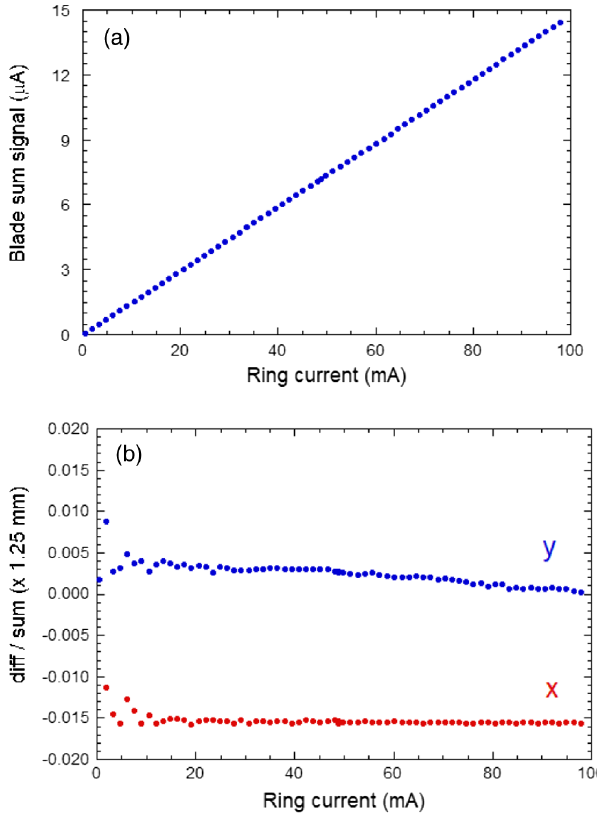
FIG. 25. (a) Variation of the sum of four blade signals with respect to the storage ring current. (b) Plot of the calculated values of difference/sum of the four blade signals with respect to the storage ring current in the horizontal (x) and vertical (y) directions.